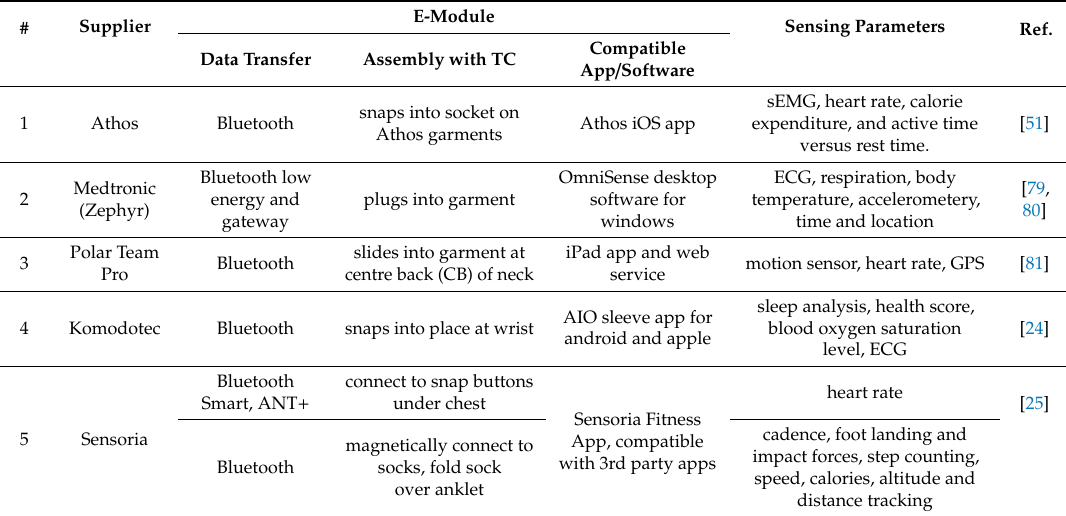
Table 5. Features of the electronics modules of available SeCSs for sports